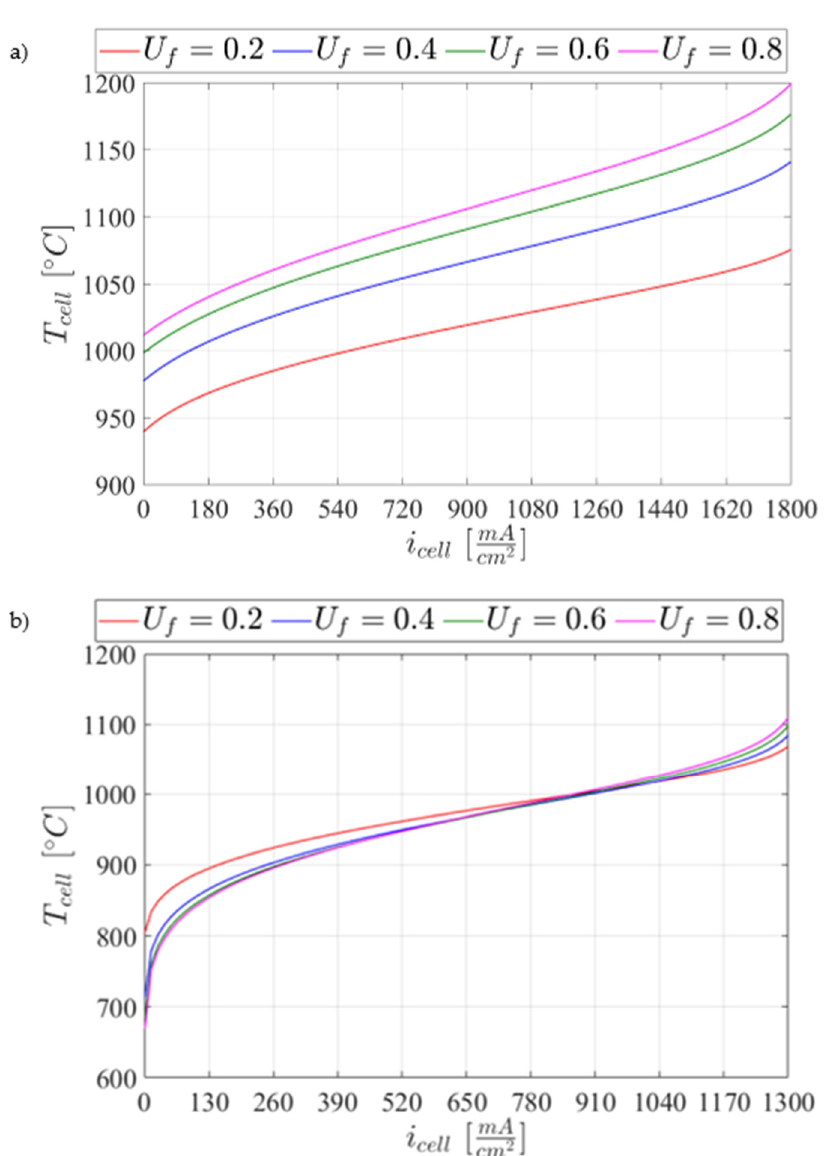
Figure 6. Temperature of the cell as a function of density current for different fuel utilization factors for the fuel cell mode ( a ) and the electrolyzer mode ( b ).